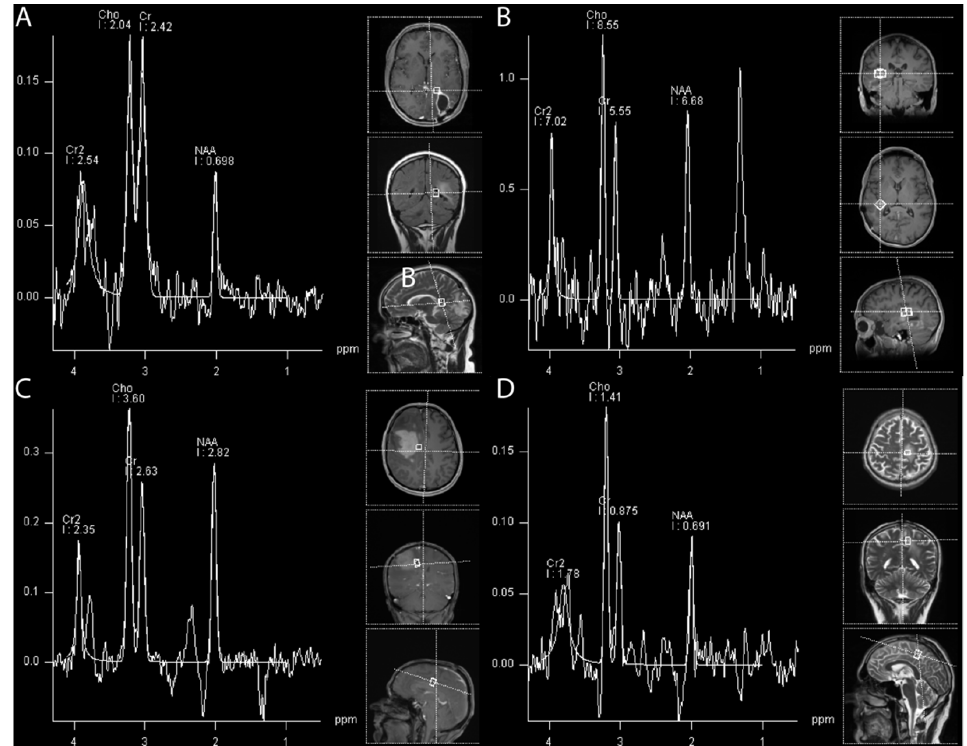
Figure 3. Assessment of treatment effect in (1H) Magnetic Resonance Spectroscopy. ( A ): True progression in a case of glioblastoma: reduced NAA, increased Cho. Cho/NAA ratio over cut-off, with a mean of 2.72. ( B ): Radionecrosis after radiosurgical treatment of a metastasis: Cho/NAA ratio with a mean of 1.46. ( C ): Pseudoprogression (glioblastoma): Cho/NAA ratio under 1.47–2.11 and Cho/Cr ration under 0.82–2.25. ( D ): Mixed image between pseudoprogression and true progression in a glioblastoma case.